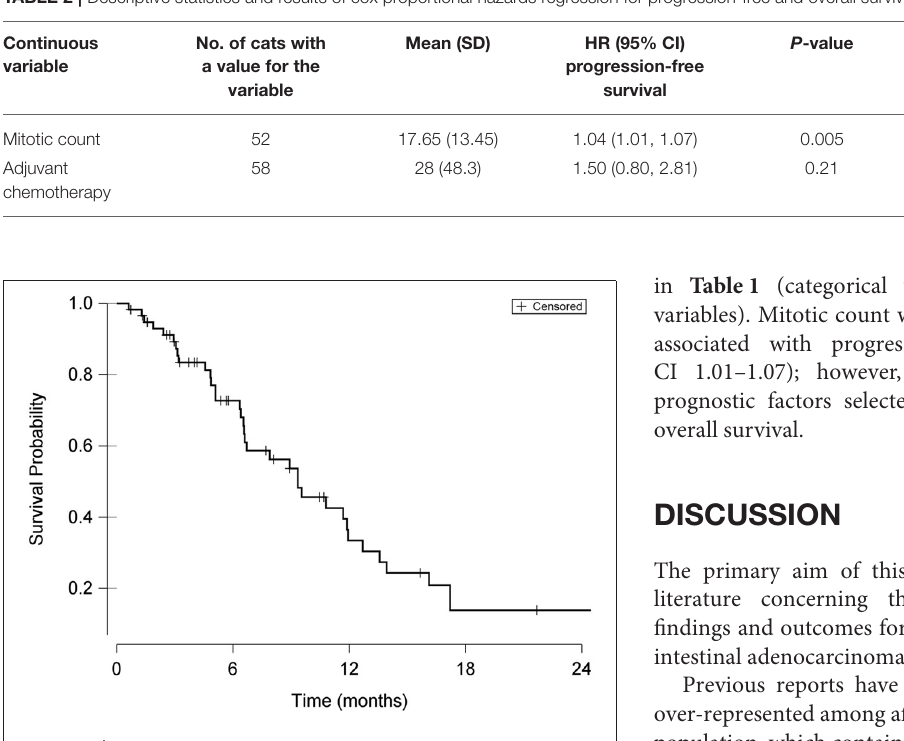
FIGURE 1 | Kaplan-Meier curve demonstrating overall survival probability from date of surgery in cats undergoing surgical resection of intestinal adenocarcinoma. Hash marks in the curve indicate times of